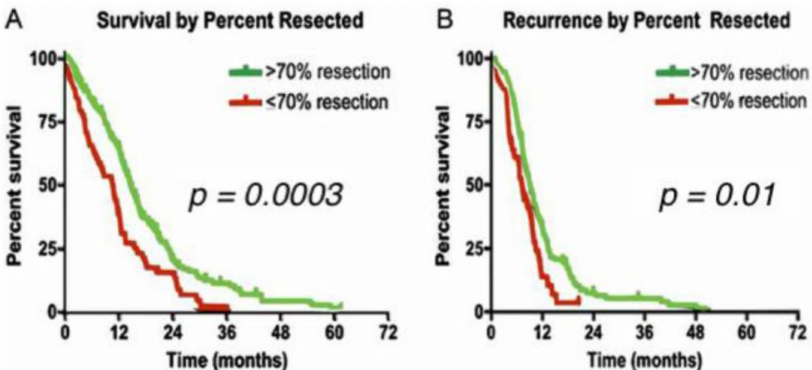
Figure 1. ( A ) Survival by extent of resection for high-grade gliomas. ( B ) Recurrence by extent of resection for high-grade gliomas. Greater than 70% extent of resection compared to less than 70% extent of resection